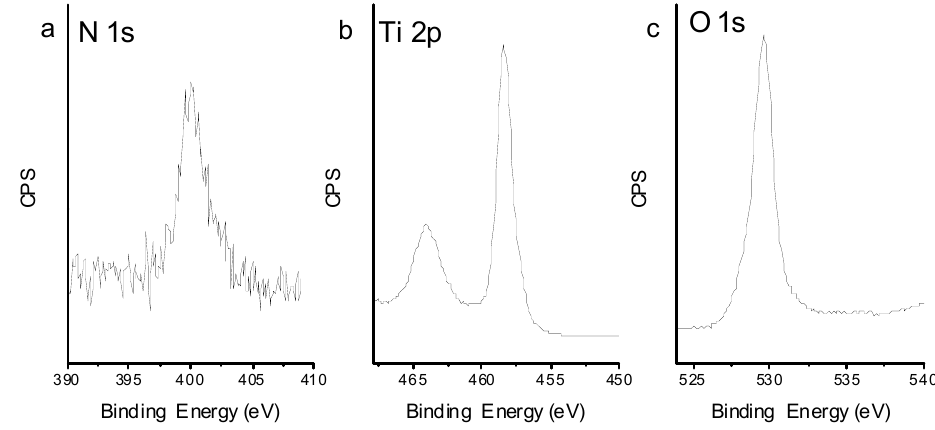
Figure 8. XPS spectra of TiO 2 -800, ( a ) N 1s spectrum, ( b ) Ti 2p spectrum, ( c ) O 1s spectrum.